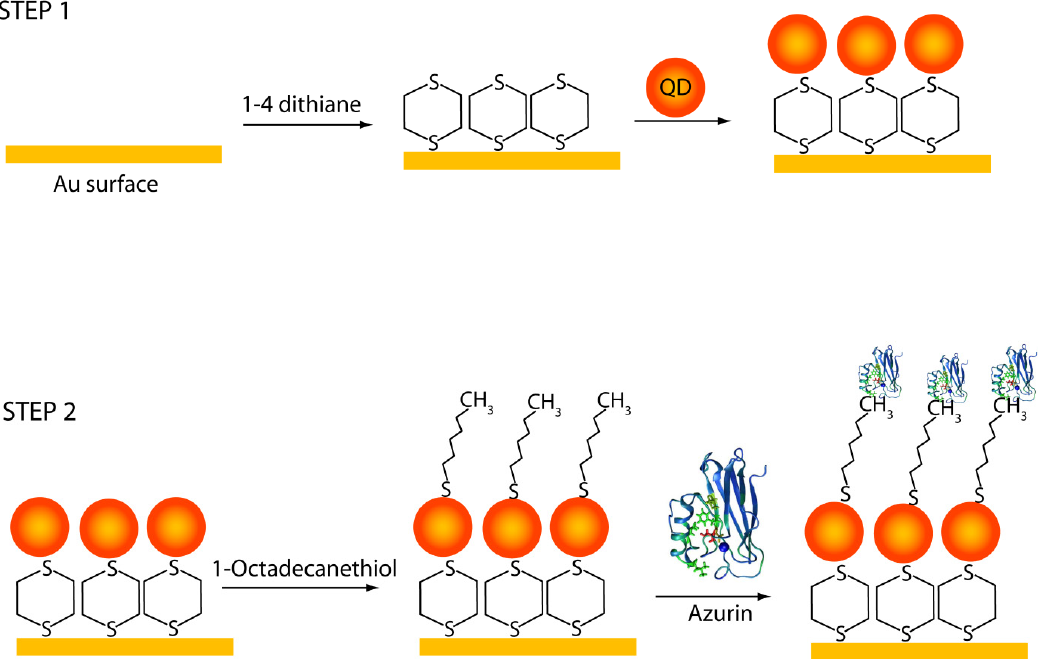
Figure 1. ( Step 1 ) Immobilization scheme of CdSe-ZnS on an Au electrode via the ligand 1,4 Dithiane; and ( Step 2 ) Immobilization strategy for azurin with CdSe-ZnS on an Au electrode where azurin was adsorbed onto a 1-octadecanethiol self-assembled monolayer, thereby forming a single bio-nano hybrid